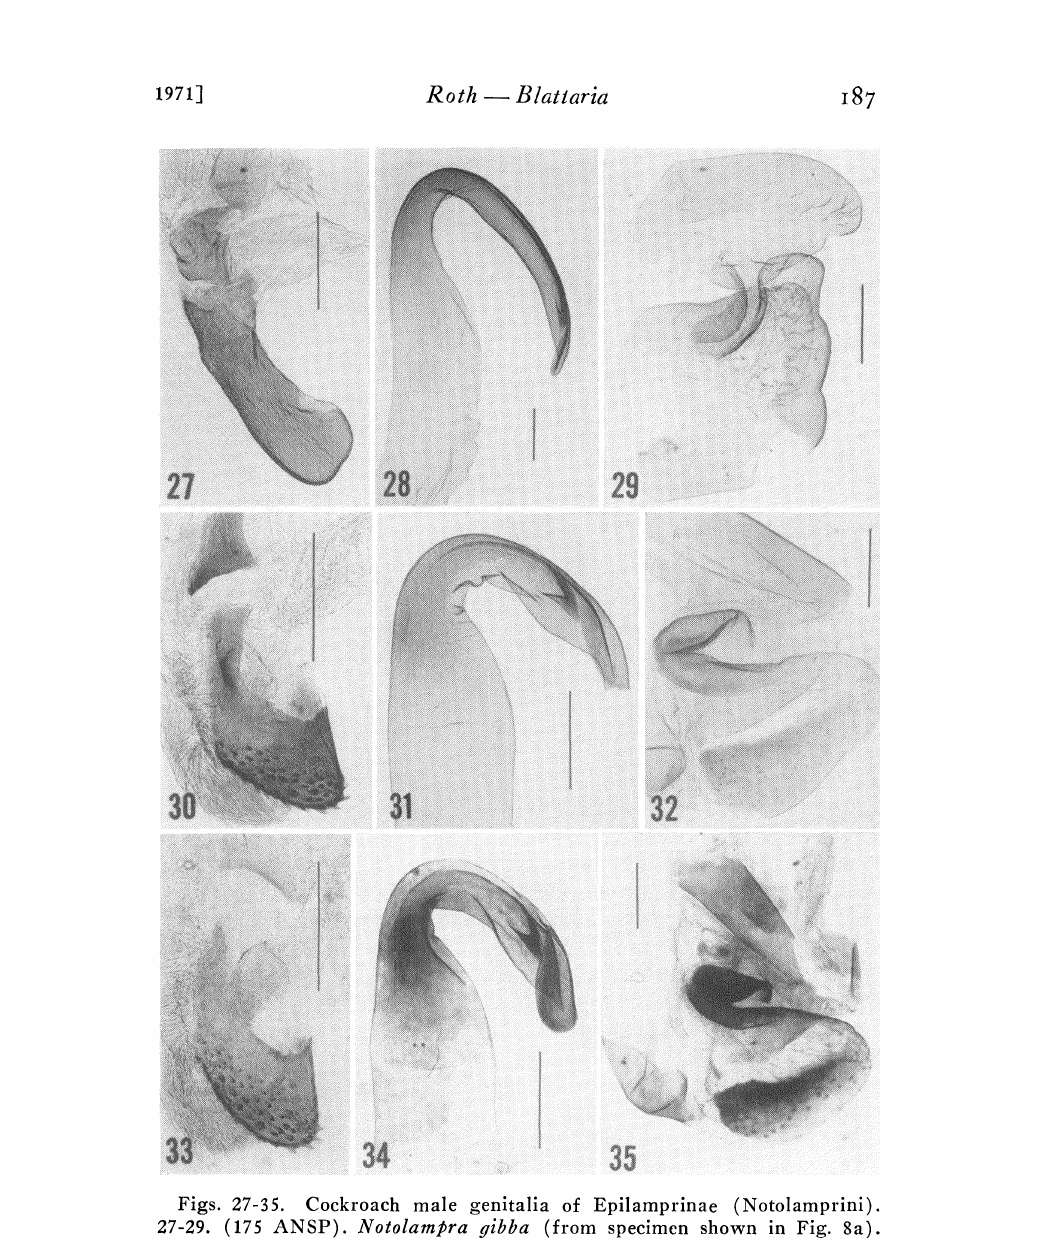
Figs. 27-35. Cockroach male genitalia of Epilamprinae (Notolamprini). 27-29. (175 ANSP). Notolampra gibba (from specimen shown in Fig. 8a). 30-35. Notolampra antillarum. 30-32. (24 BMNH). Trinidad. 33-35. (1469 L). (from specimen shown in Fig. 6). (det. Princis). (scale 0.3